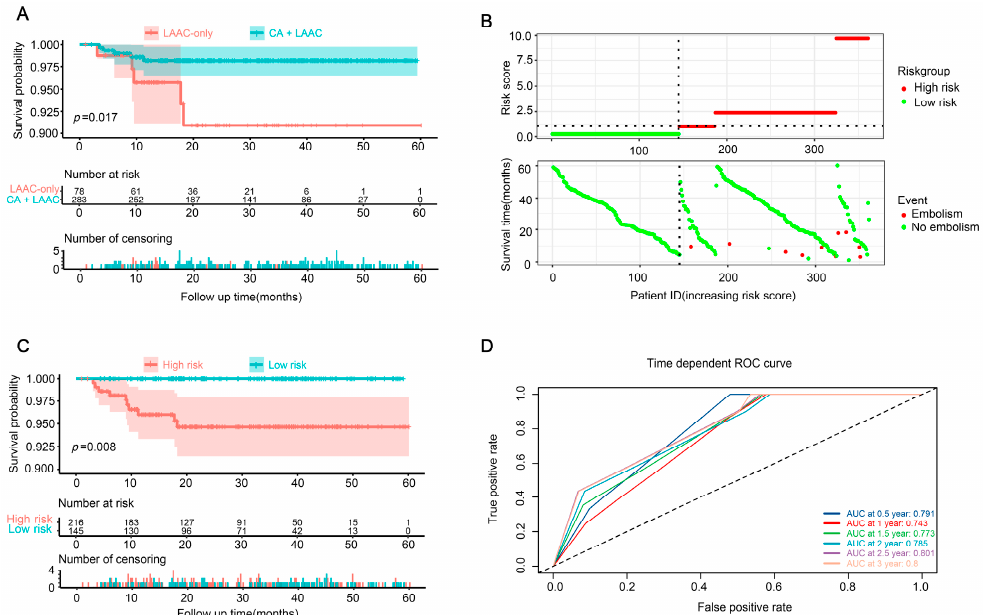
Figure 2. Embolization in patients with AF after procedure. ( A ) The KM survival analysis of patients with post-procedural embolization in groups LAAC-only and CA + LAAC. ( B ) Establishment of a risk scoring model for CSCC; risk score distribution of high-risk group and low-risk group (up), and survival profile of high-risk group and low-risk group (down). ( C ) The KM analysis of high-risk and low-risk populations from ( A ). ( D ) ROC curve analysis of 0.5-year, 1-year, 1.5-year, 2-year, 2.5-year and 3-year overall survival by risk score. CA = catheter ablation; LAAC = left atrial appendage closure; KM = Kaplan–Meier; CSCC = colorectal squamous cell carcinoma; ROC = receiver operating characteristic.